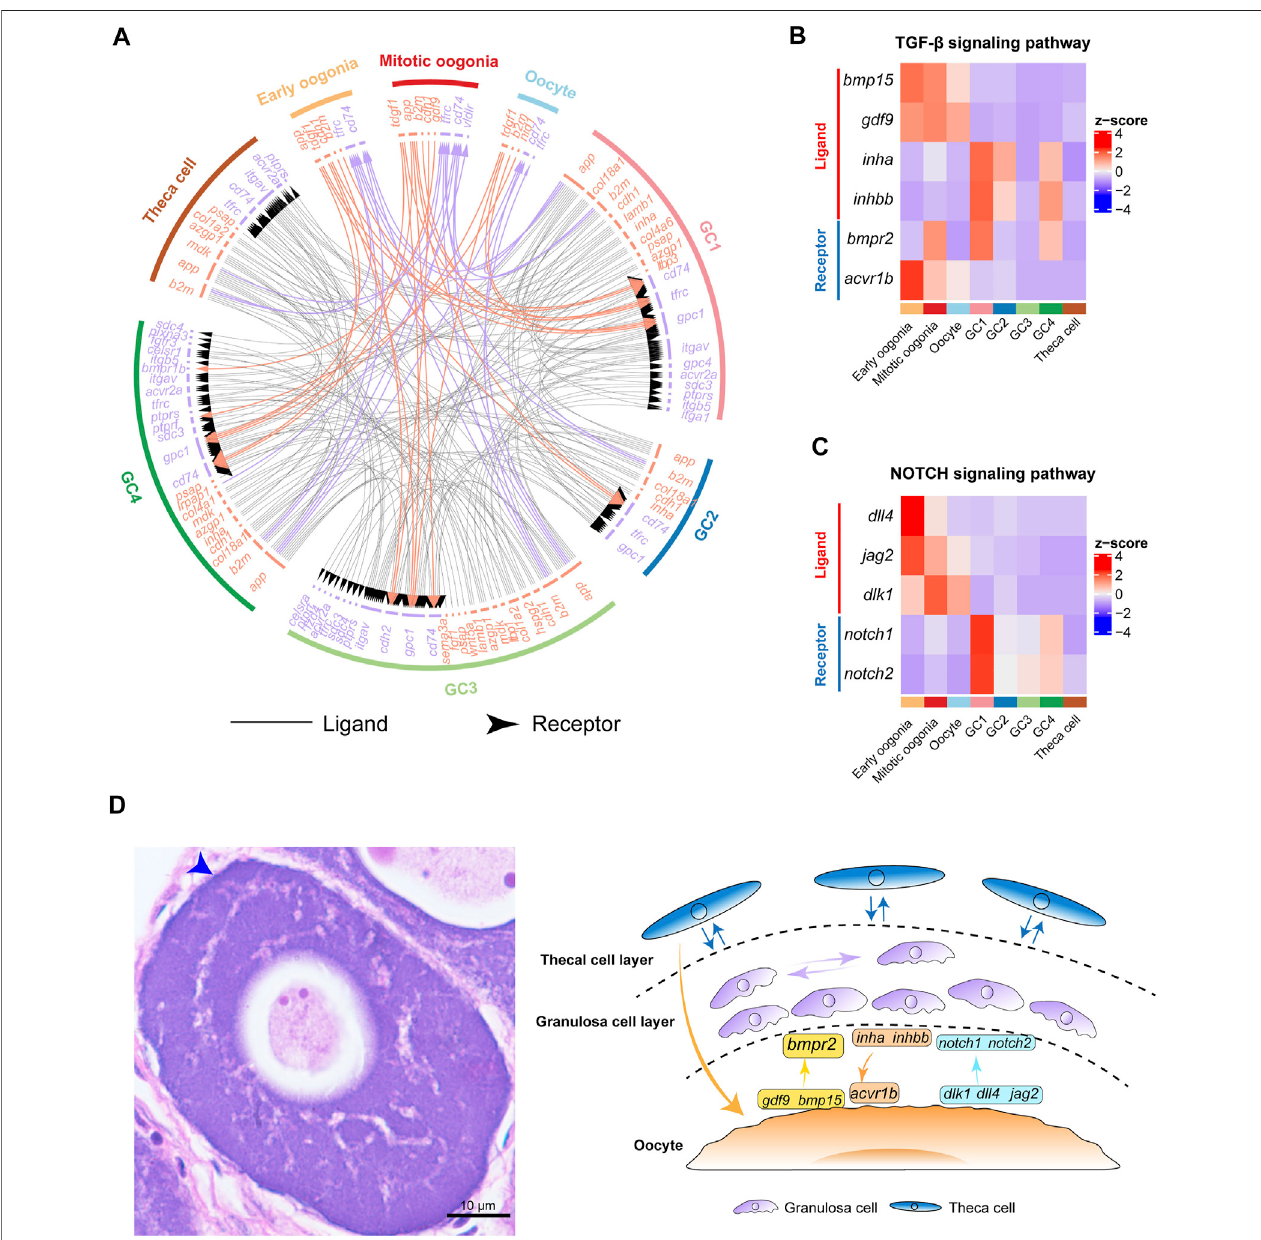
FIGURE 4 | Cell – cell communication networks and signaling pathways involved in fi sh oogenesis. (A) The multilineage interactome network among different cell clusters. Associated interaction pairs are shown. (B) Heatmap showing the expression pattern of ligands and receptors of the TGF- β signaling pathway. (C) Heatmap showstheexpressionpatternofligandsandreceptorsoftheNOTCHsignalingpathway. (D) Left:H&EstainingofovarysectionsfromfemaleChinesetonguesole.Scale bars represent 10 μ m. The blue arrow shows double cell layers of follicle. Right: Schematic summary of interactions involved in fi sh oogenesis.